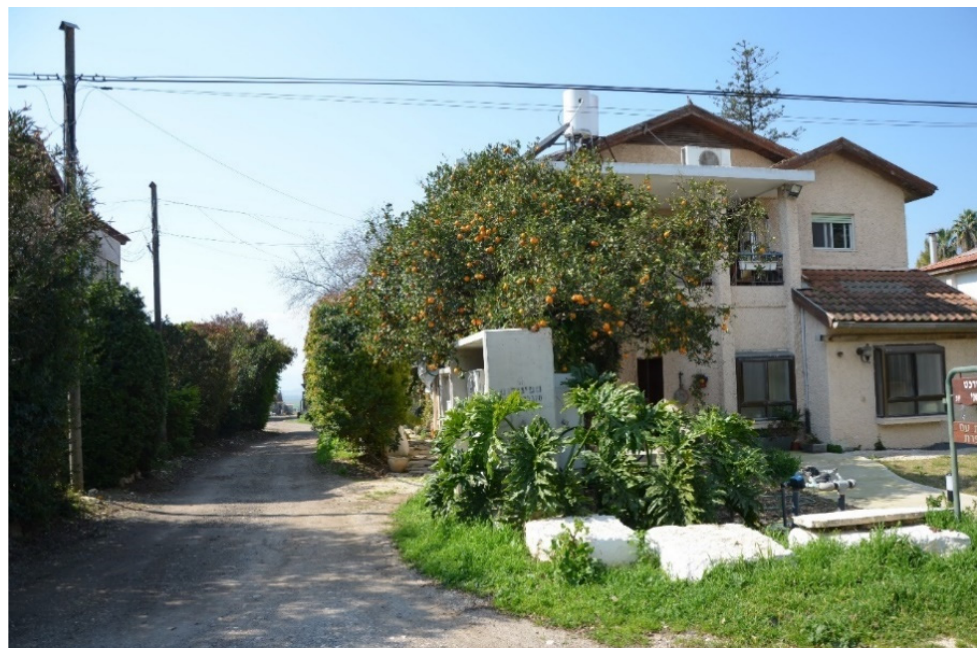
Figure 11. Infrastructure buildings in Nahalal that can be used for the regeneration of the rural cen- ter. Photo by the authors.